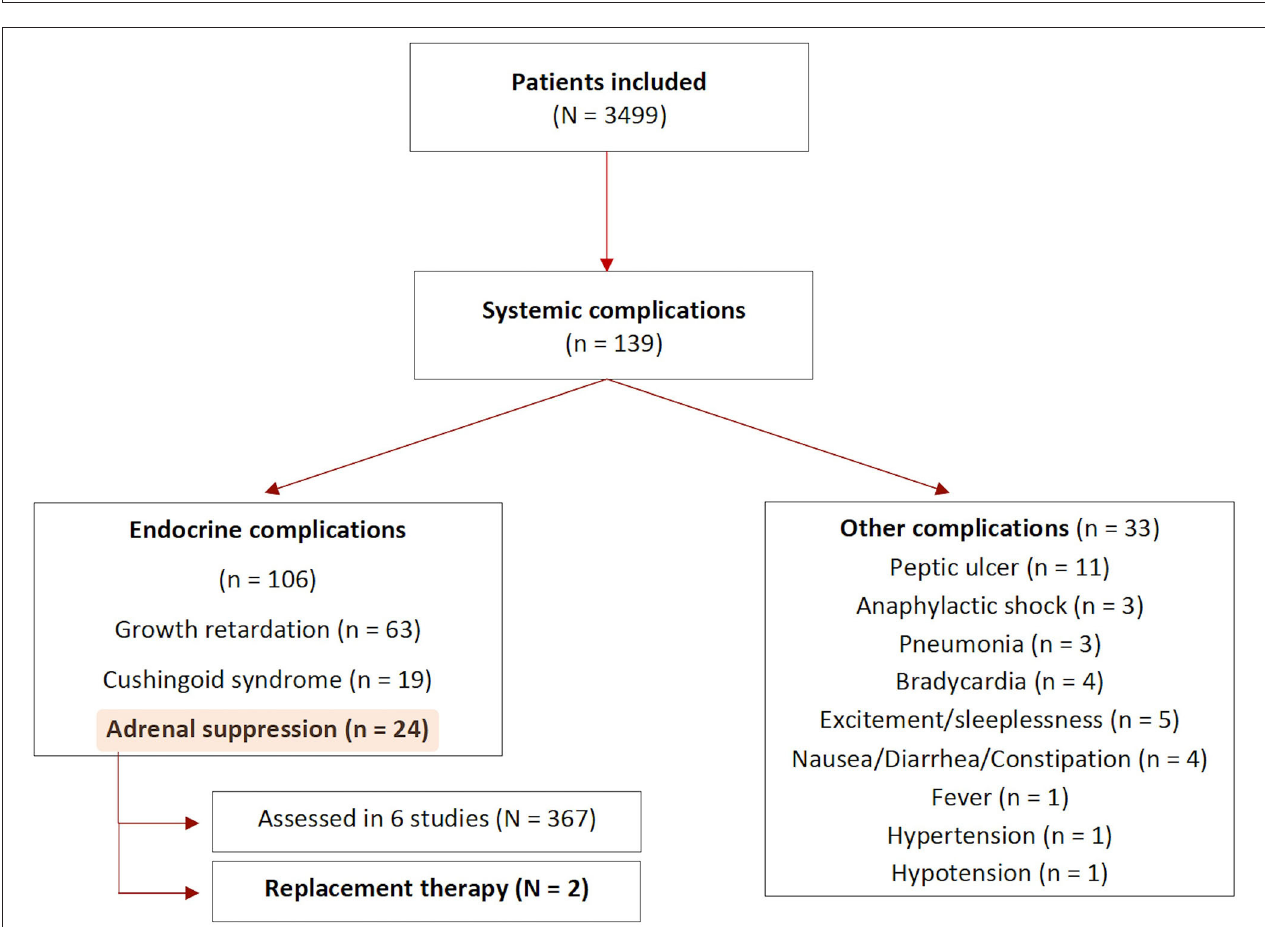
FIGURE 4 | Summary of the systemic complications. N, number of patients; n, number of complications.